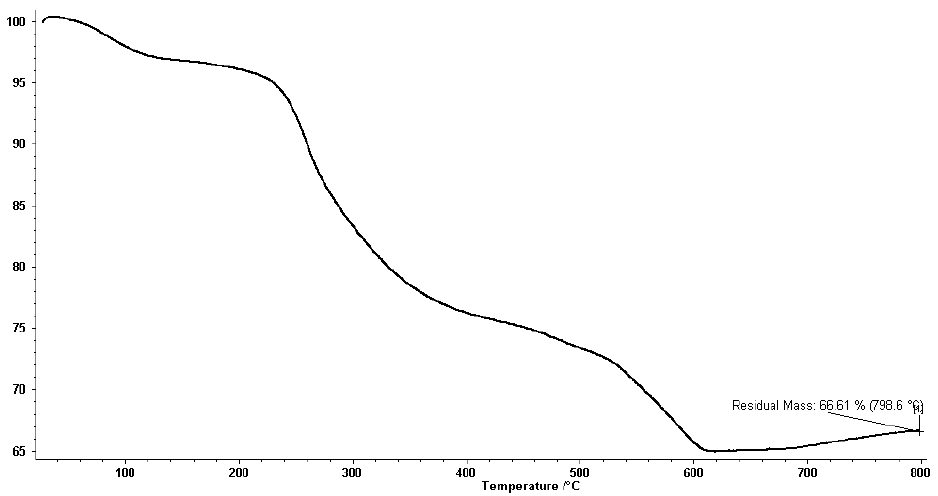
Figure 4. Thermogravimetric analysis (TGA) curve of NiFe 2 O 4 -NPs.